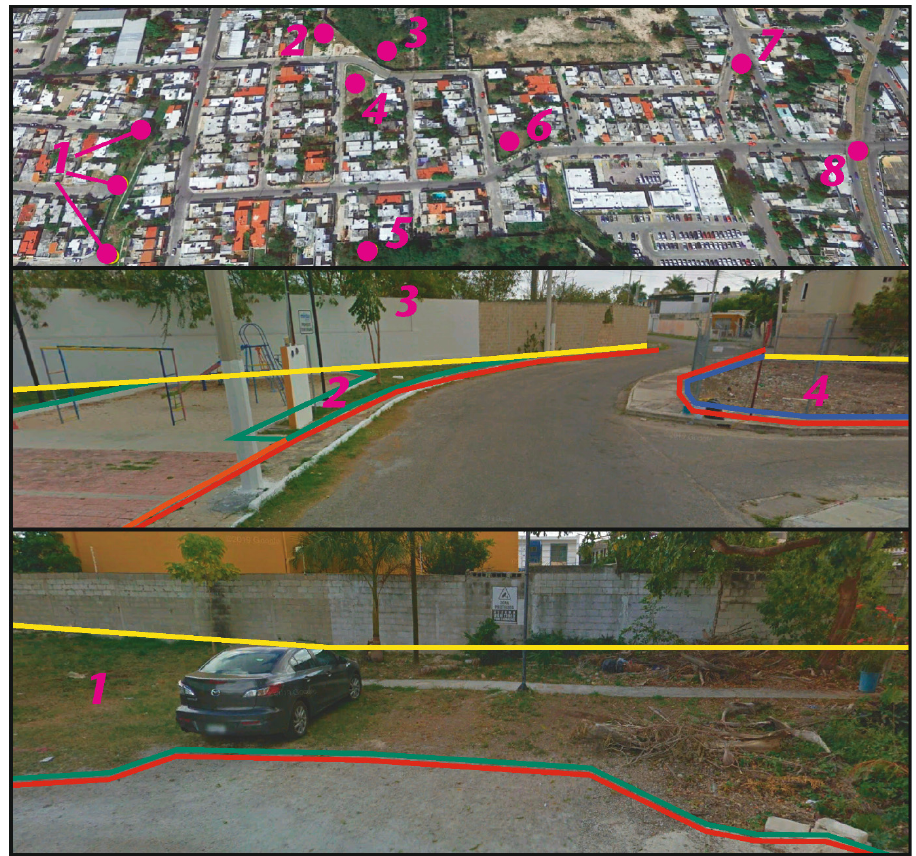
Figure 2. We exemplify how soil edge mapping could be applied, using a number of occurrences of urban soil in the Roma neighbourhood of Mérida, Yucatán. The numbers in the top aerial photograph indicate the following urban soil situations: (1) soils found in the margins of built space, presumably public space, which are highly accessible and especially proximal to residents of the adjacent street; (2) publicly accessible soils, part of a park and playground maintained by the municipality; (3) soil contained as part of the grounds of an educational institution, which would be at times accessible through membership of the educational community and may be maintained in part to serve specific activities; (4) soil contained on an as yet undeveloped private and fenced plot, inaccessible to the public; (5) soil supporting an area of vibrant vegetation, devoid of clear access ways, surrounded by development, it is unclear if this is private or public land; (6) soil contained in a privately run parking lot, to which the public have paid access, but not to engage with soils, which sole purpose may be to support grass vegetation to keep the area neat; (7) soil supporting select trees and vegetation as part of gardens may look deceptively green while concealing that the soil itself is virtually sealed unto the stems of that vegetation; and (8) soil wedged in between a major traffic artery (part of a disused railway), which is highly accessible to any member of the public when traversing, but remains underused. The lower parts show the street scenes of situations 1–4. The yellow edge indicates the inaccessibility of urban soils due to impermeable walling. The green edges indicate publicly accessible soils without physical restrictions. The orange edge indicates sealed soil with some permeability (here, tiles or sand). The blue edge indicates visible yet inaccessible soil as part of private land. The red edges indicate impermeably sealed soils by concrete and tarmac surfaces, only mitigated by cracks formed by ageing. (Background images credit: Google Earth ©